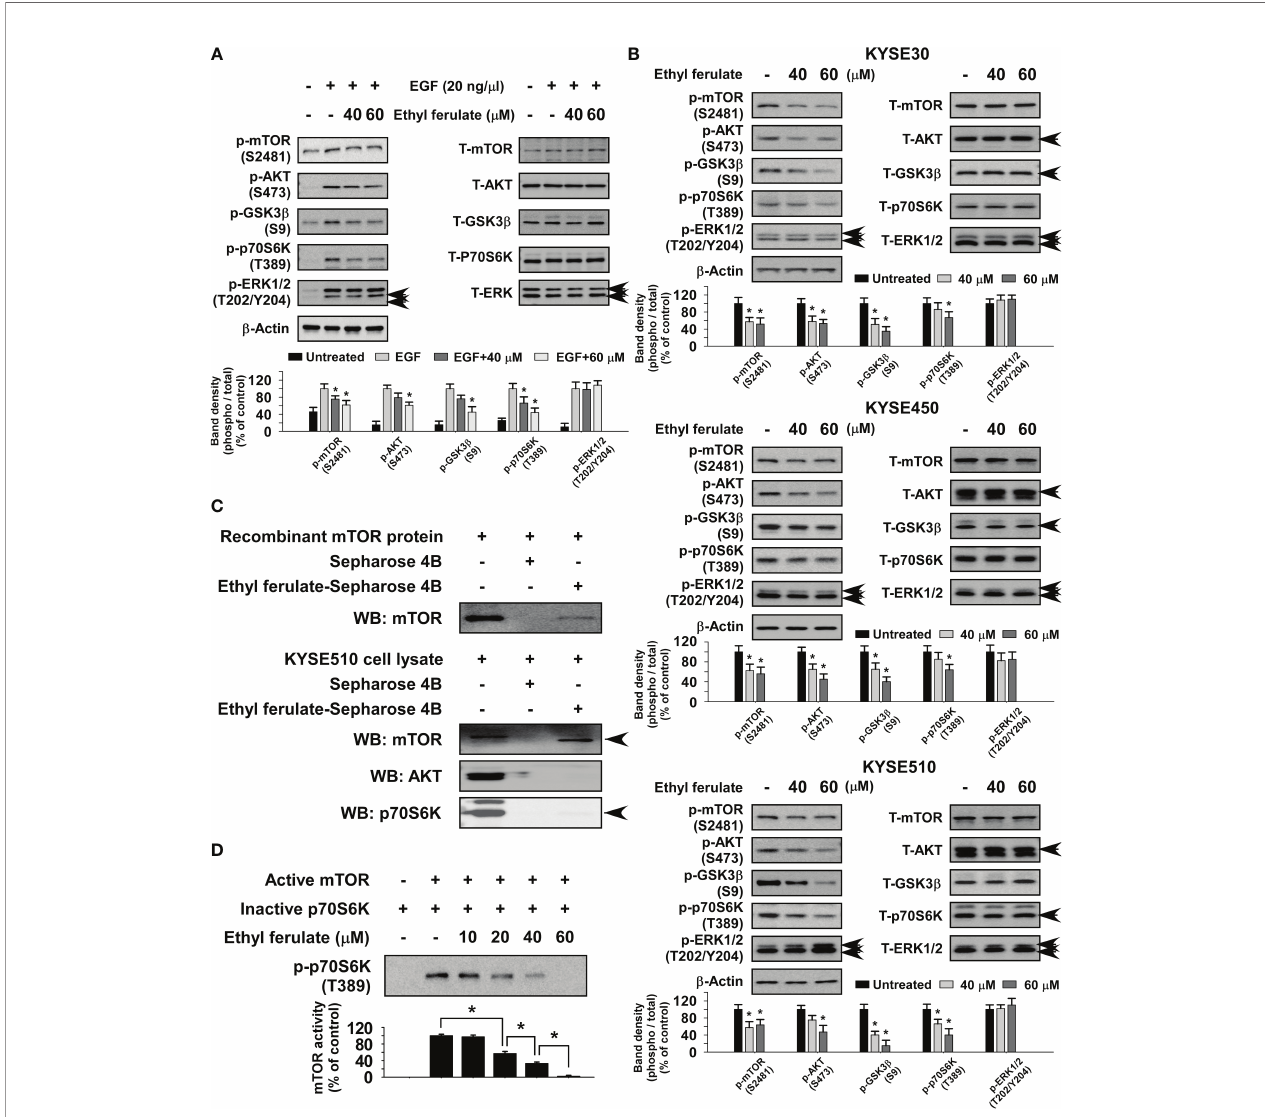
FIGURE 3 | Ethyl ferulate strongly inhibits the mammalian target of rapamycin (mTOR) signaling pathway. (A) The effect of ethyl ferulate on epidermal growth factor (EGF)-induced kinase signaling in JB6 cells. Serum-starved [without fetal bovine serum (FBS); 24 h] cells were treated with different concentrations of ethyl ferulate for 6 h followed by treatment with EGF for 30 min. (B) The effect of ethyl ferulate on various kinase signaling proteins in esophageal squamous cell carcinoma (ESCC) cells. Cells were treated with ethyl ferulate for 24 h, and then various signaling proteins were examined by Western blotting. (C) Ethyl ferulate directly binds to recombinant mTOR protein and mTOR present in KYSE510 cell lysates. The recombinant mTOR protein or cell lysate was incubated with Sepharose 4B beads or ethyl ferulate-conjugated Sepharose 4B beads. Pulled down proteins were examined by Western blotting. (D) The effect of ethyl ferulate on mTOR kinase activity. mTOR kinase activity was assessed by in vitro kinase assay using active mTOR and inactive p70S6K proteins. For all experiments, similar results were shown as mean values ± SD for 3 independent experiments and band density is shown as a bar graph. One-way analysis of variance (ANOVA) was used to analyze the data. The asterisk (*) indicates a signi fi cant ( P < 0.05) inhibitory effect of ethyl